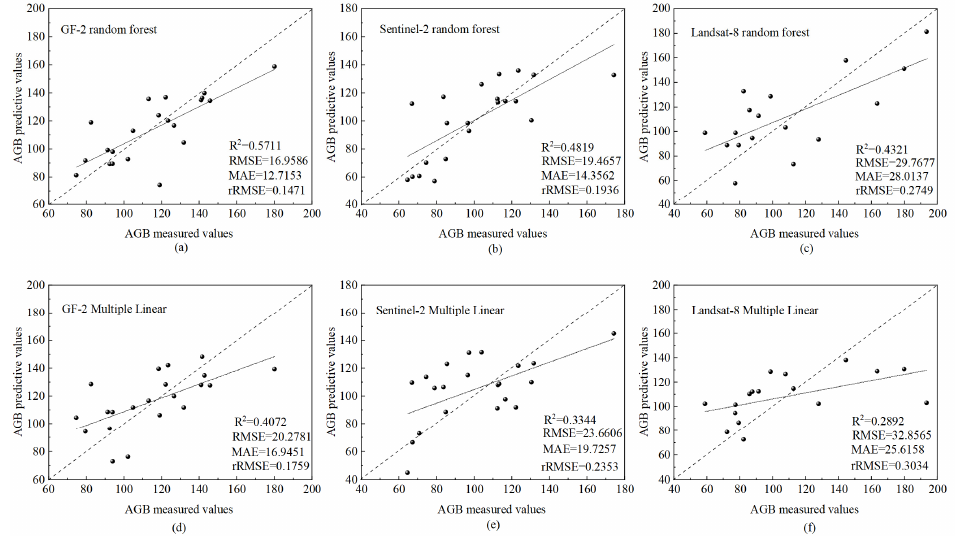
Figure 4. Scatter plot between measured and estimated AGB (black dotted line indicates y = x ). ( a ) the scattering plot of measured and estimated AGB of GF ‐ 2 by using random forest model; ( b ) the scattering plot of measured and estimated AGB of Sentinel ‐ 2 by using random forest model; ( c ) the scattering plot of measured and estimated AGB of Landsat ‐ 8 by using random forest model; ( d ) the scattering plot of measured and estimated AGB of GF ‐ 2 by using multiple linear model; ( e ) the scat ‐ tering plot of measured and estimated AGB of Sentinel ‐ 2 by using multiple linear model; ( f ) the scattering plot of measured and estimated AGB of Landsat ‐ 8 by using multiple linear model.